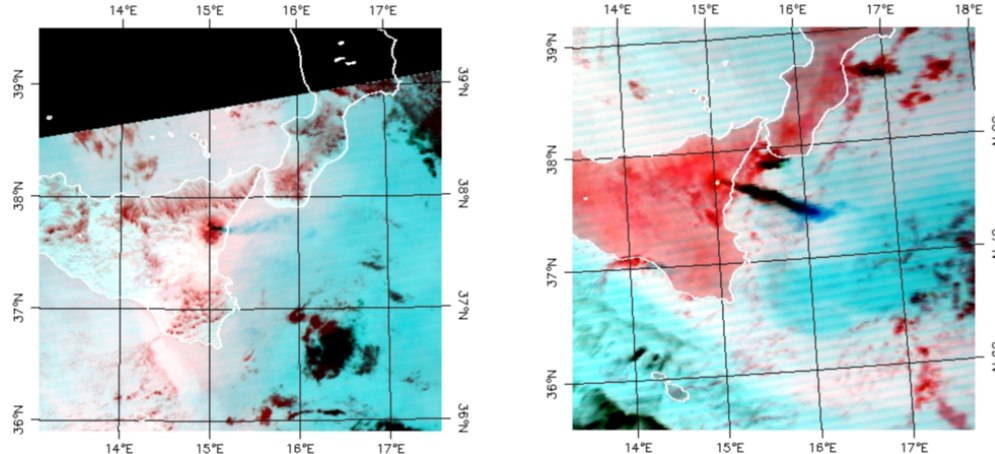
Fig. 8. MODIS RGB image composite (channels 28, 29, and 31) for the two test cases considered: 3 December 2006 – 12:10UTC – MODIS- Aqua (left), and 23 October 2011 – 21:30UTC – MODIS-Terra (right). Table 3. SO 2 and ash total masses and mean fluxes ( v is the wind speed used) for the two MODIS test case images. All the results were obtained considering the plume only over the